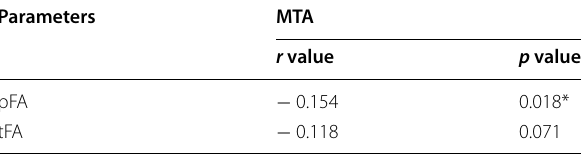
Table 2 Pearson correlation coefficients between